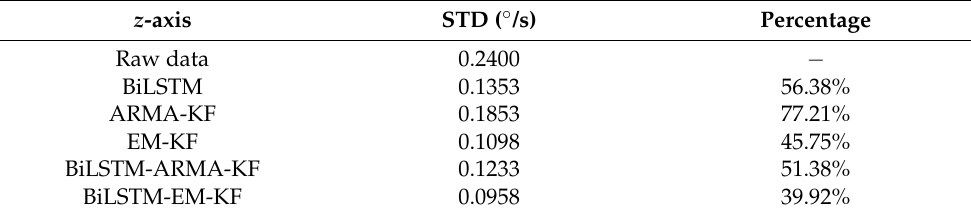
Table 11. Comparison of raw data, BiLSTM, ARMA-KF, EM-KF, BiLSTM-ARMA-KF, and BiLSTM-EM-KF standard deviation values for z -axis data.